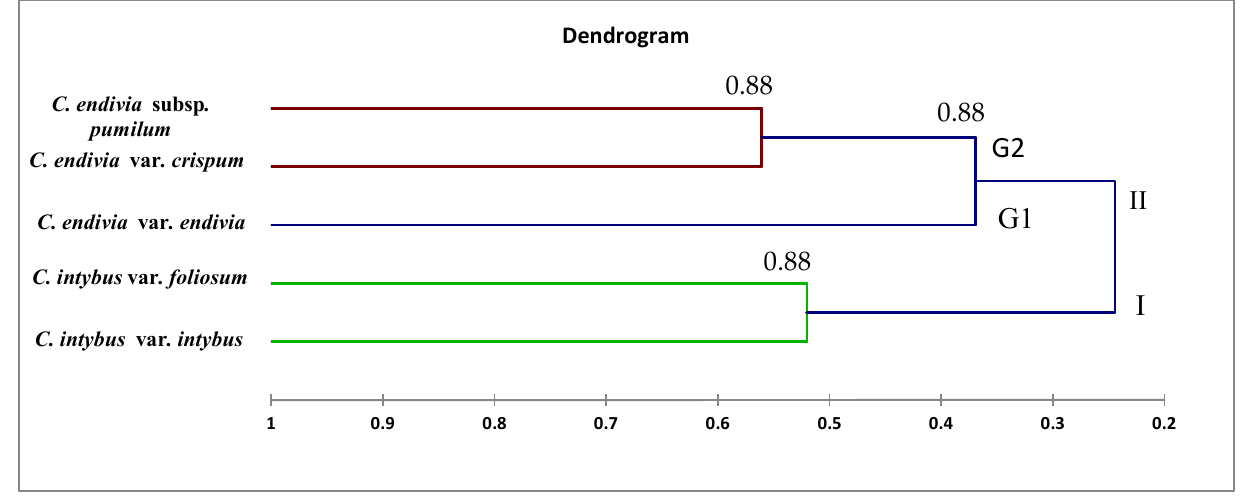
13 of 22 Figure 9. Dendrograms classified the five taxa of Cichorium by three molecular markers using UP- GMA analysis. The dataset was investigated using clustering analysis to identify and differentiate the taxa. The cluster analysis (Figure 10) showed that species were categorized into two major clusters, and Cluster II was further split into two groups. The first one consisted of two taxa— C. intybus var. intybus and C. intybus var. foliosum. Cluster II comprised three taxa and was further divided into two groups: Group 1 contained one taxon C. endivia var.